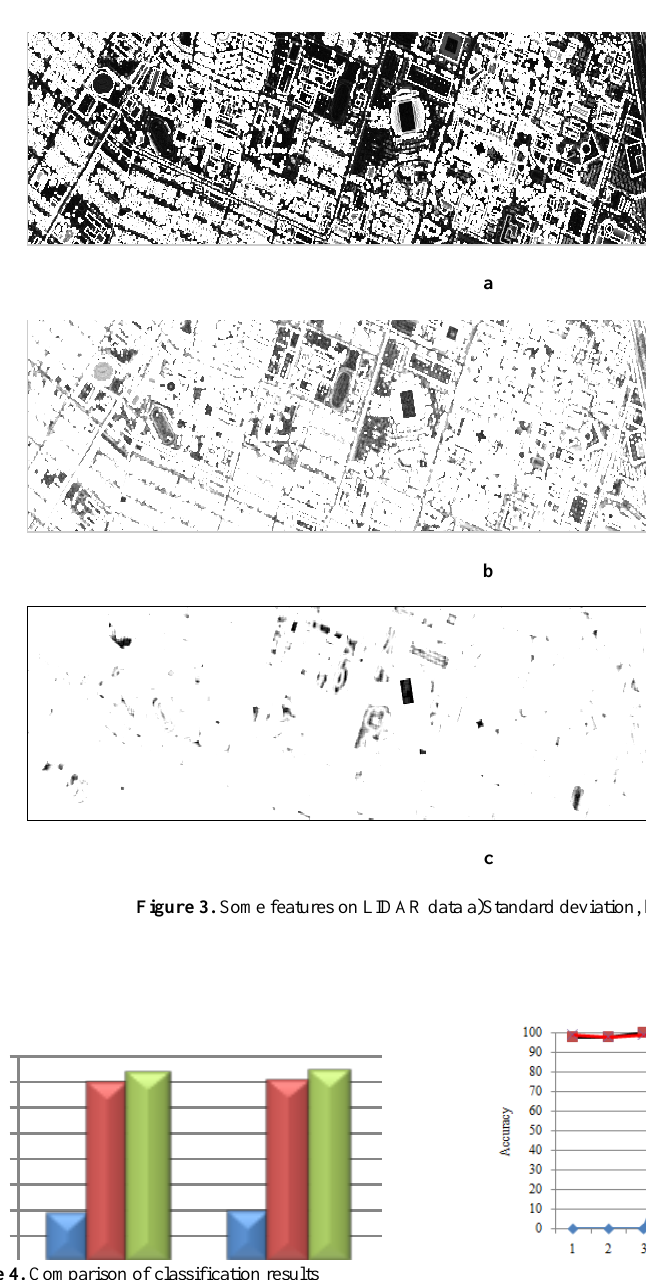
Figure 4. Comparison of classification results